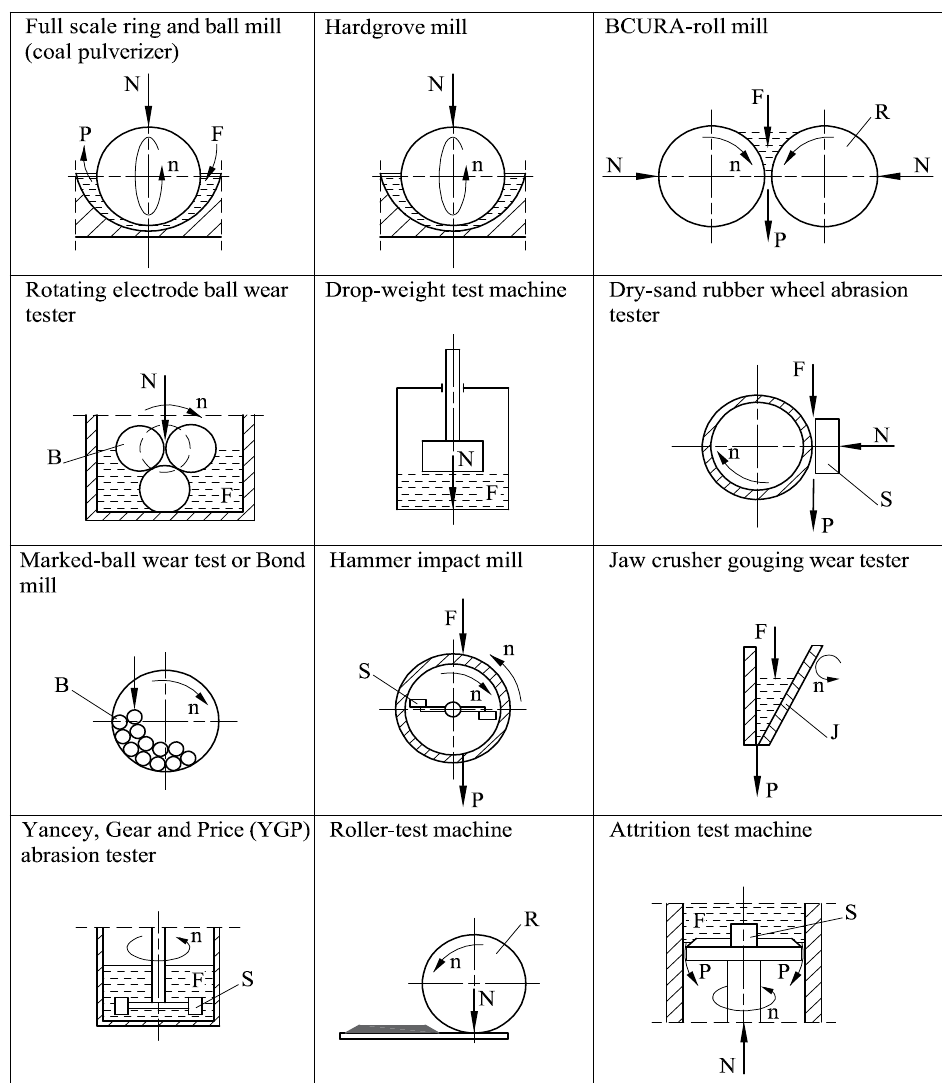
Figure 2. Test methods for grindability and abrasion testing: Full scale ring and ball mill, Hardgrove mill [30,31], BCURA-roll mill, Rotating electrode ball wear tester [32], Drop-weight test machine [28], Dry-sand rubber wheel abrasion tester [33], Marked-ball wear test or Bond mill [34], Hammer impact mill [35], Jaw crusher gouging wear tester [36], Yancey, Gear and Price (YGP) abrasion tester [37], Roller-test machine [29], Attrition test machine [21,35,38] , where: N—normal load, F—feed, P—product, n—number of revolution per minute, R—roller, B—steel ball, S—specimen, J—rotating jaw.